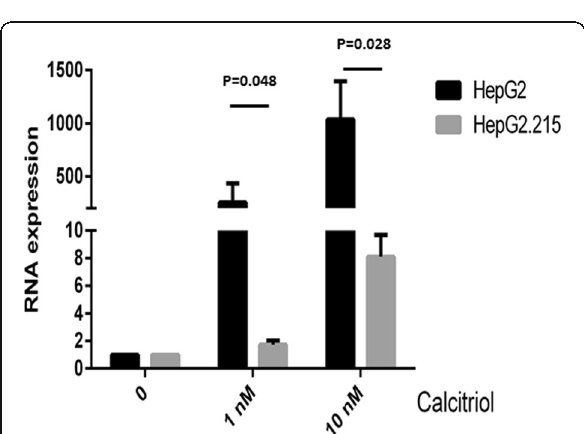
Fig. 4 Up-regulation in CYP24A1 expression level as a result of calcitriol treatment is attenuated in HBV-transfected cells. HepG2.2.15 and HepG2 cells were treated with either 1 nM or 10 nM of Calcitriol or with EtOH, as a control. 24 h later, the cells were harvested and CYP24A1 transcript levels were measured using RT-PCR. (HepG2 vs HepG2 HepG2.2.15 (1 nM) p = 0.048, HepG2 vs HepG2 HepG2.2.15 10 nM p = 0.028). Results are expressed as mean ± standard